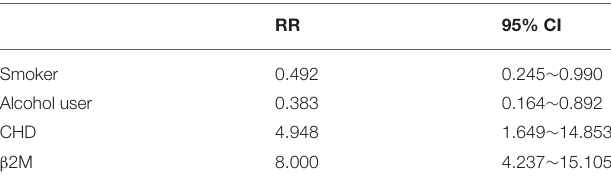
FIGURE 1 | Receiver operating curve (ROC) showed predictive serum level of β 2M for poor outcome. TABLE 3 | Risk factors for poor 3-month outcomes in acute ischemic stroke (AIS) patients ( N =